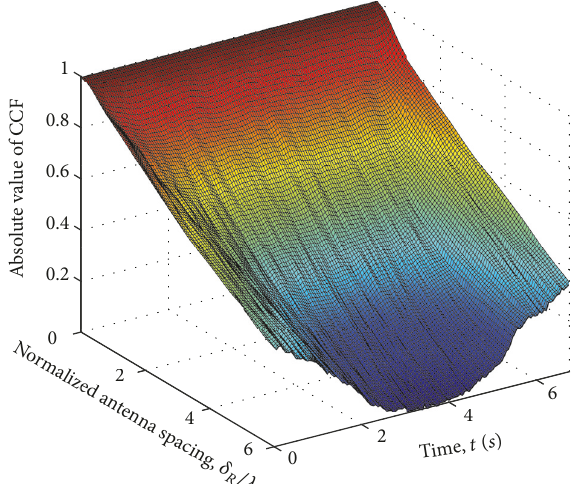
Figure 9: Absolute values of the theoretical TV-CCF |𝜌 𝑝𝑞,𝑝 󸀠 𝑞 󸀠 (𝑡,𝛿 𝑅 )| ( 𝐾 𝑝𝑞 = 0).